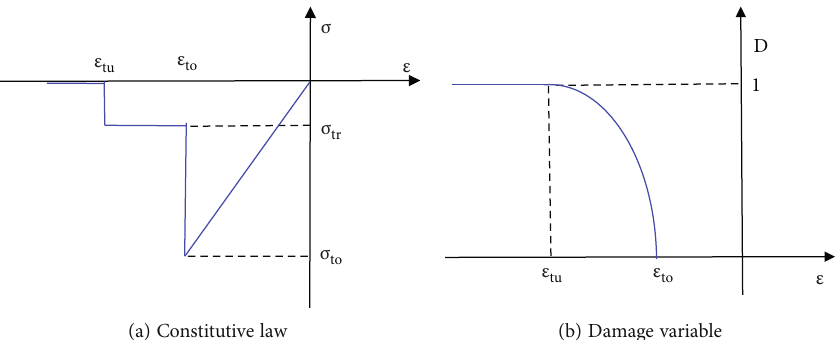
Figure 3: Constitutive law and damage variable in tensile failure